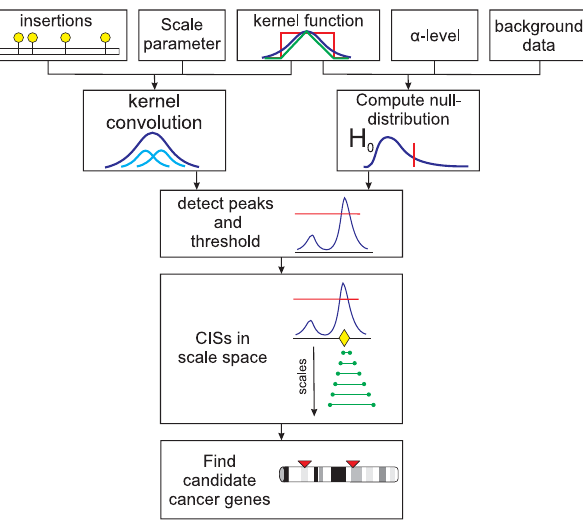
Figure 2. Schematic Depiction of the Kernel Convolution Framework The insertions are convolved with a kernel function with a width determined by the scale parameter. In principle any kernel function can be used, but the Gaussian kernel function is depicted. The significance of the peaks is evaluated using a null-distribution computed by means of a random permutation of the data. This is done for a range of scale parameters to obtain the CISs in the scale space.